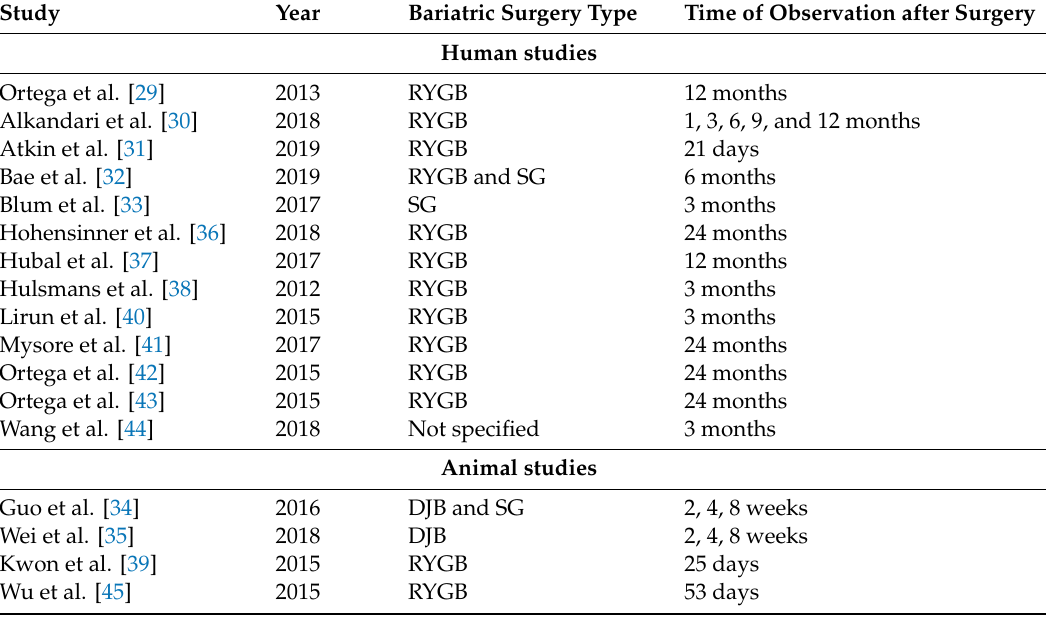
Table 3. Bariatric surgery type and time of observation after